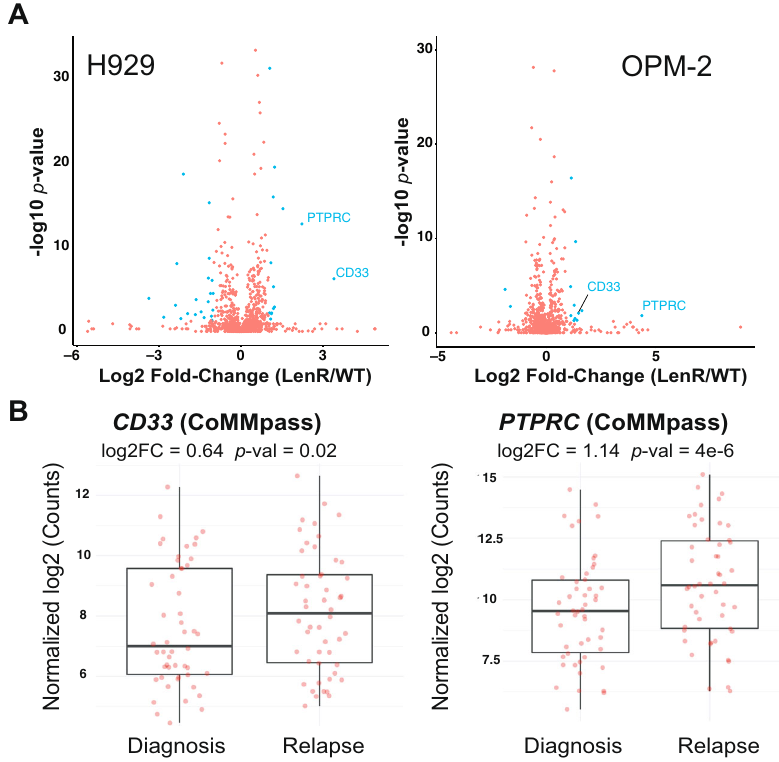
Fig. 4 Surface proteomic signatures of lenalidomide resistance. A In vitro-evolved lenalidomide-resistant H929 and OPM-2 lines were analyzed by cell- surface proteomics with comparison to parental lines by SILAC quanti fi cation ( n = 4 biological replicates; heavy and light channels swapped for two replicates each). Signi fi cantly-changed proteins in blue (log 2 -fold change > |1|; p < 0.05 by t -test), with only CD33 and PTPRC/CD45 showing common changes between the two lines. Source data in Supplementary Data 6. B MMRF CoMMpass patient transcript data con fi rms signi fi cant increase in CD33 and PTPRC at fi rst relapse versus diagnosis (Release IA14, n = 50 patients), suggesting that increases in these surface proteins is driven by IMiD resistance. For B , upper and lower hinges correspond to 25 and 75 percentiles, center line indicates the median, and upper and lower whiskers extend to highest and lowest values within 1.5* IQR of the